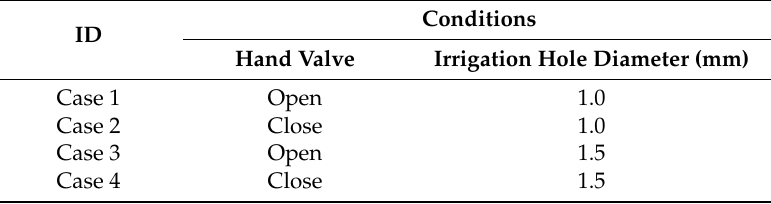
Table 5. Experimental conditions.